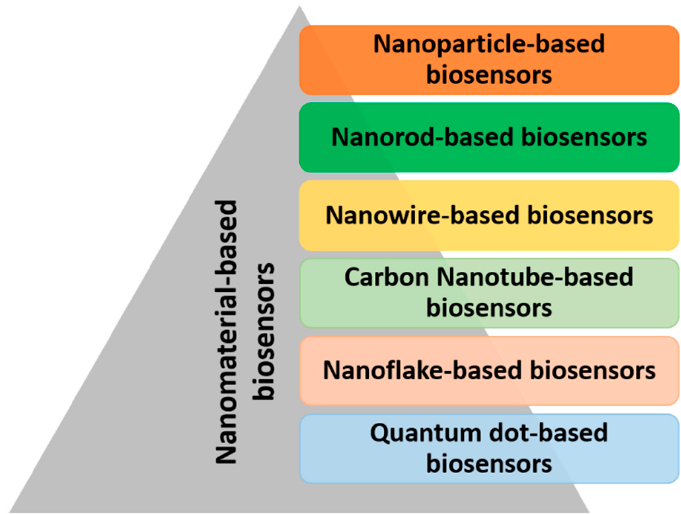
Figure 4. Types of nanomaterial-based biosensors (nano-biosensors). Table 2. Nanomaterials used in the development of biosensors.